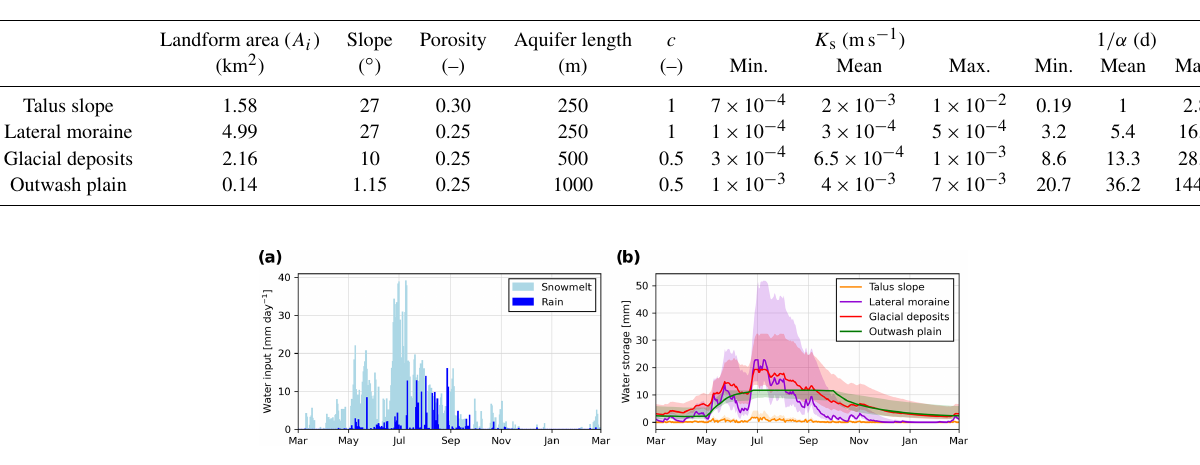
Table 3. Estimated recession constant (1 /α ) based on aquifer characteristics of the entire Otemma catchment for the main landform com- partments. c stands for the slope coefficient of Eq. (4) and was defined as 1 when the aquifer slope is larger than 10 ◦ .